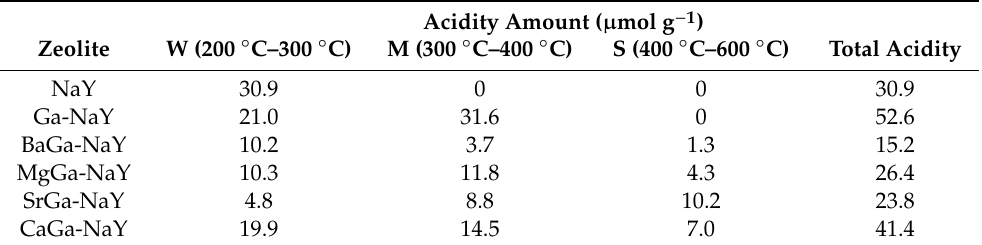
Table 2. Acid properties of di ff erent zeolites studied by NH 3